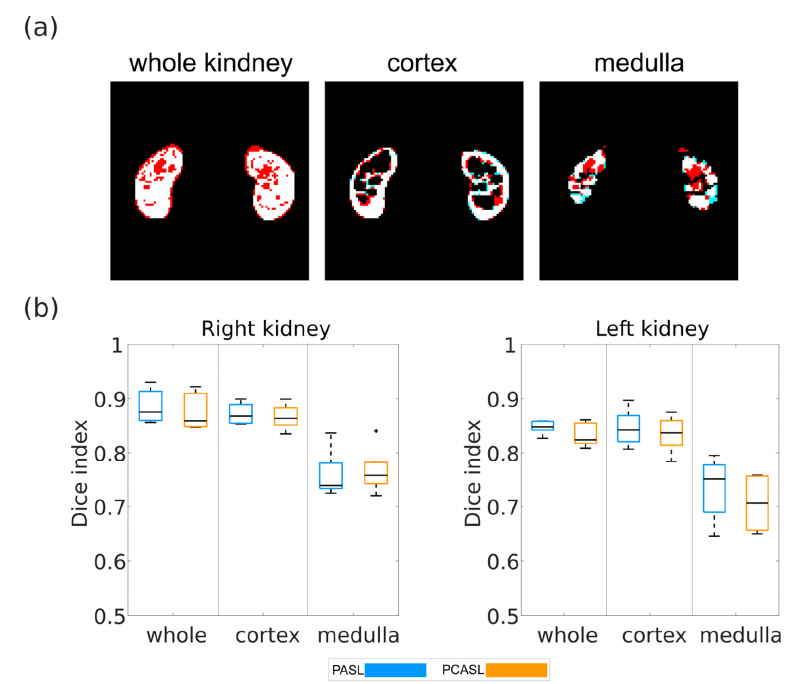
Figure 5. ( a ) Comparison of segmentation masks of the PCASL data set of model 108 obtained from the processing pipeline (red) and the XCAT phantom (cyan). White areas correspond to pixels pre- sent in both masks being compared. ( b ) Boxplots of Dice indices calculated for the five models for the PASL and PCAL data sets for whole kidney, cortex, and medulla. The black line in each boxplot shows the median of the distribution of mean perfusion across all models. The top and bottom part of each boxplot represent the 25th and 75th percentiles. The boxplots’ whiskers extend to the highest and lowest data points not considered as outliers. Outliers are shown a black ‘+’.